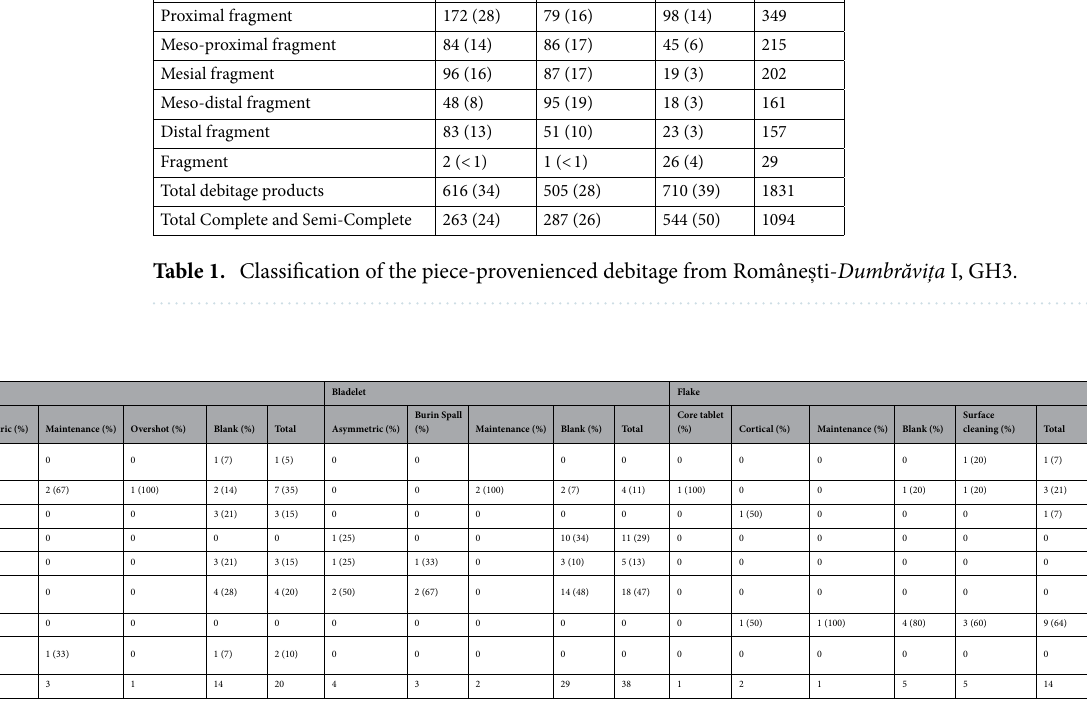
Table 2. Classification of retouched blade, bladelet and flakes from Române ș ti- Dumbrăvi ț a I, GH3.